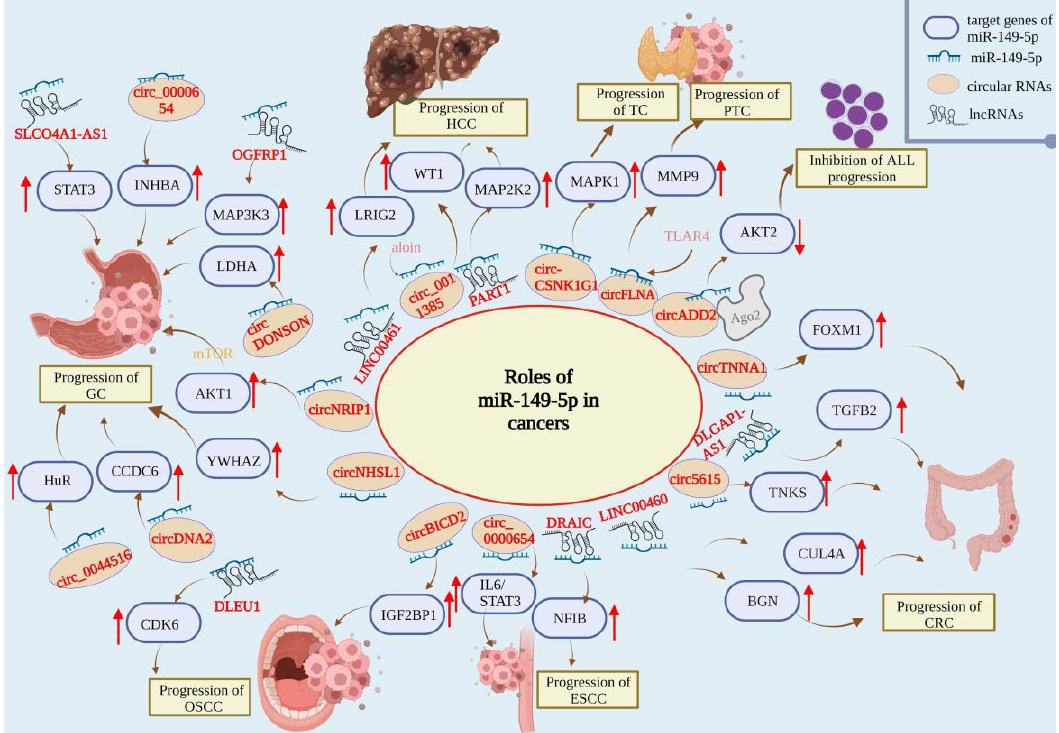
Figure 1. Roles of miR-149-5p in papillary thyroid cancer (PTC), thyroid cancer (TC), acute lymphoblastic leukemia (ALL), hepatocellular carcinoma (HCC), gastric cancer (GC), colorectal cancer (CRC), oral squamous cell carcinoma (OSCC), and esophageal squamous cell carcinoma (ESCC).